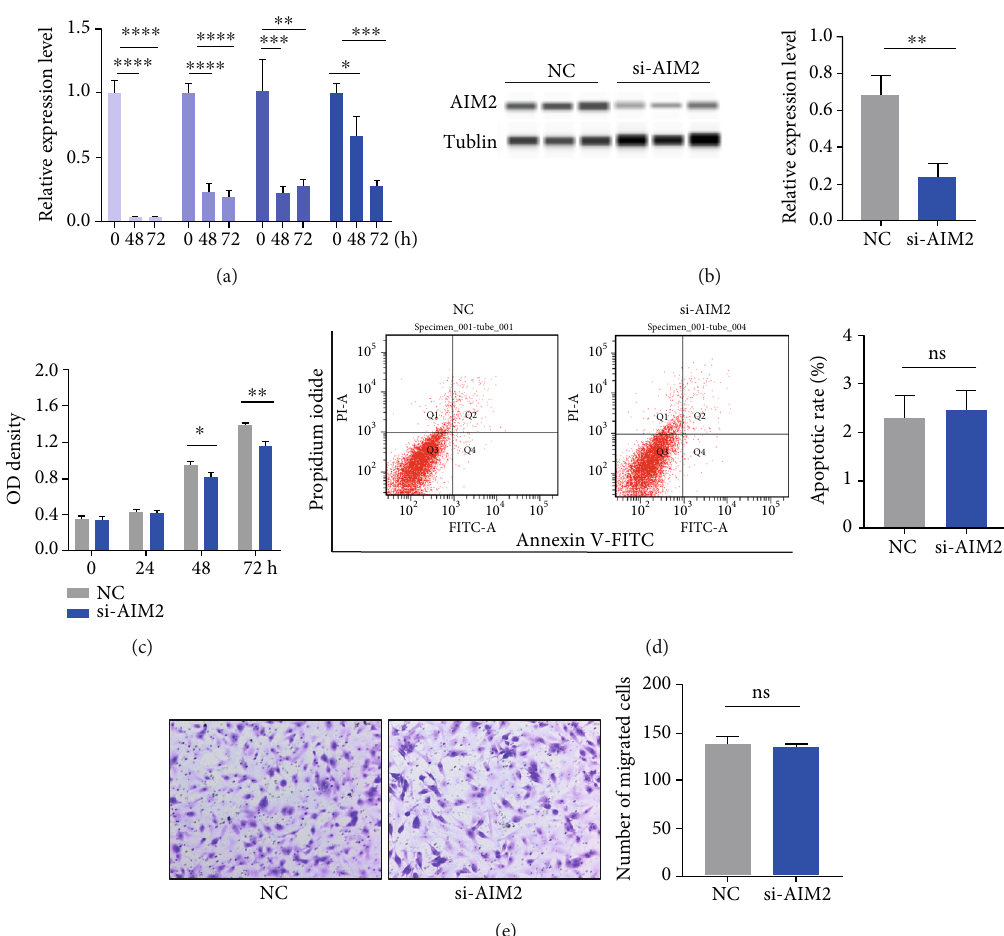
Figure 5: Proliferation, apoptosis, and migration assay of RA-FLS after si-AIM2 transfection. AIM2 and its downstream proteins including ASC, caspase-1, and IL-1 β were successfully silenced after 24 h of transfection (a). Western blot con fi rmed the successful silencing of the AIM2 expression by si-AIM2 (b). The proliferation of RA-FLS was inhibited after 48 h of transfection (c). There were no signi fi cant di ff erences between the NC and si-AIM2 groups in apoptosis and migration assay (d, e). ∗ p < 0 : 05 , ∗∗ p < 0 : 01 , ∗∗∗ p < 0 : 001 , and ∗∗∗∗ p < 0 : 0001